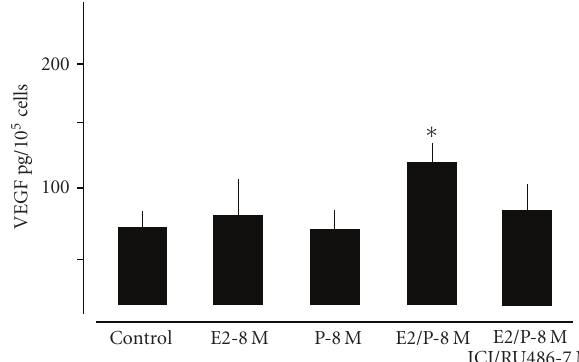
Figure 7: Quantification of VEGF protein release of alveolar cells type II treated for 48h with E2-8M and P-8M alone or in combination determined by ELISA. Note that corresponding with results obtained by gene expression analysis (Figure 6) VEGF protein is increased in alveolar type II cell cultures only by combined treatment with E2 and P. Pretreatment with ICI/RU 486 abrogated this e ff ect. ∗ P < . 05 control versus E2/P-8M.